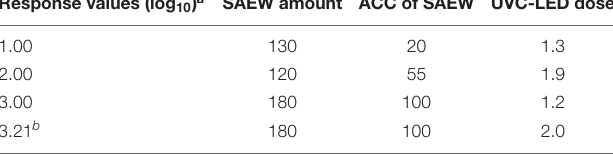
TABLE 3 | Target response values according to combined disinfection conditions using sprayed slightly acidic electrolyzed water (SAEW) treatment and ultraviolet C-light-emitting diode (UVC-LED)